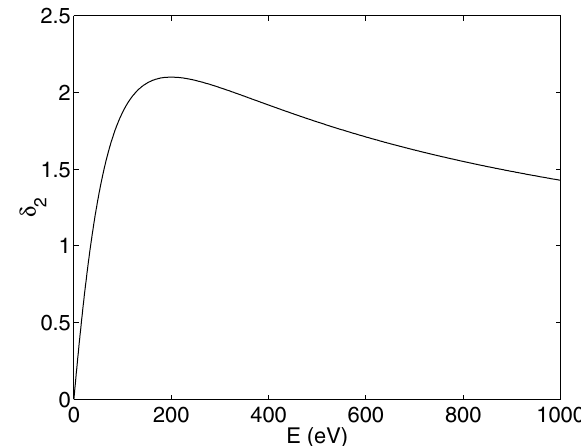
FIG. 1. Secondary electron yield depending on incident elec- (cid:5) 2 : 1 and E (cid:5) 200 eV tron energy for (cid:13) 2 ; max max